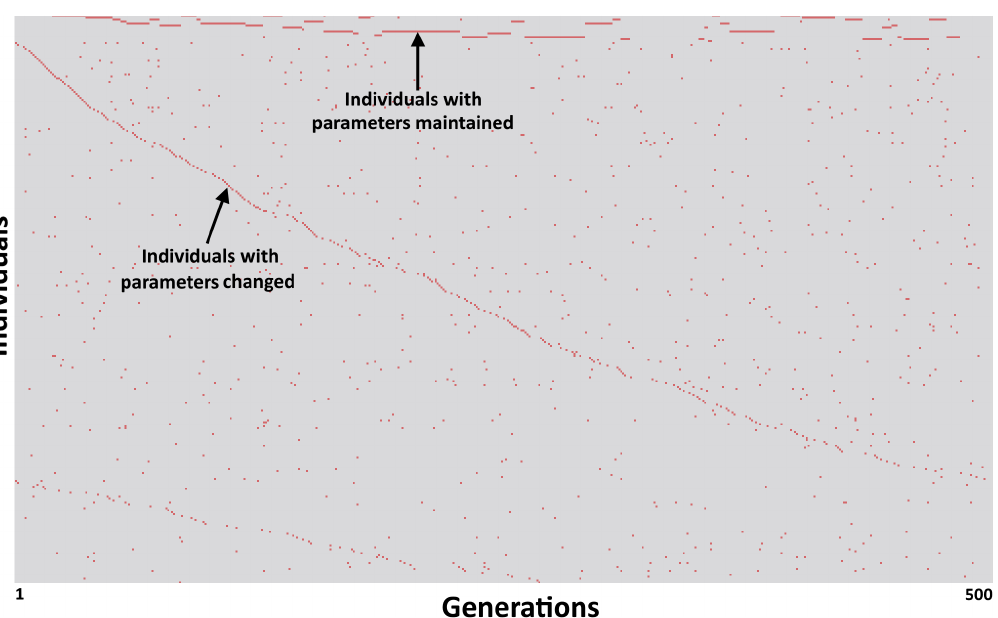
Figure 7. The occurrences of individuals with fitness of more than 99.5% created along the